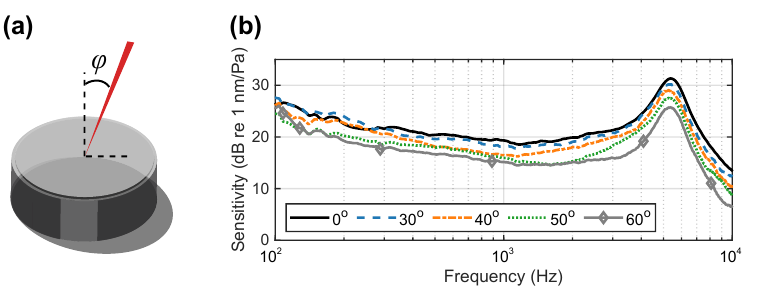
Figure 10. ( a ) Incidence of the laser beam with an angle ϕ . ( b ) Sensitivity of the membrane specimen with different incoming